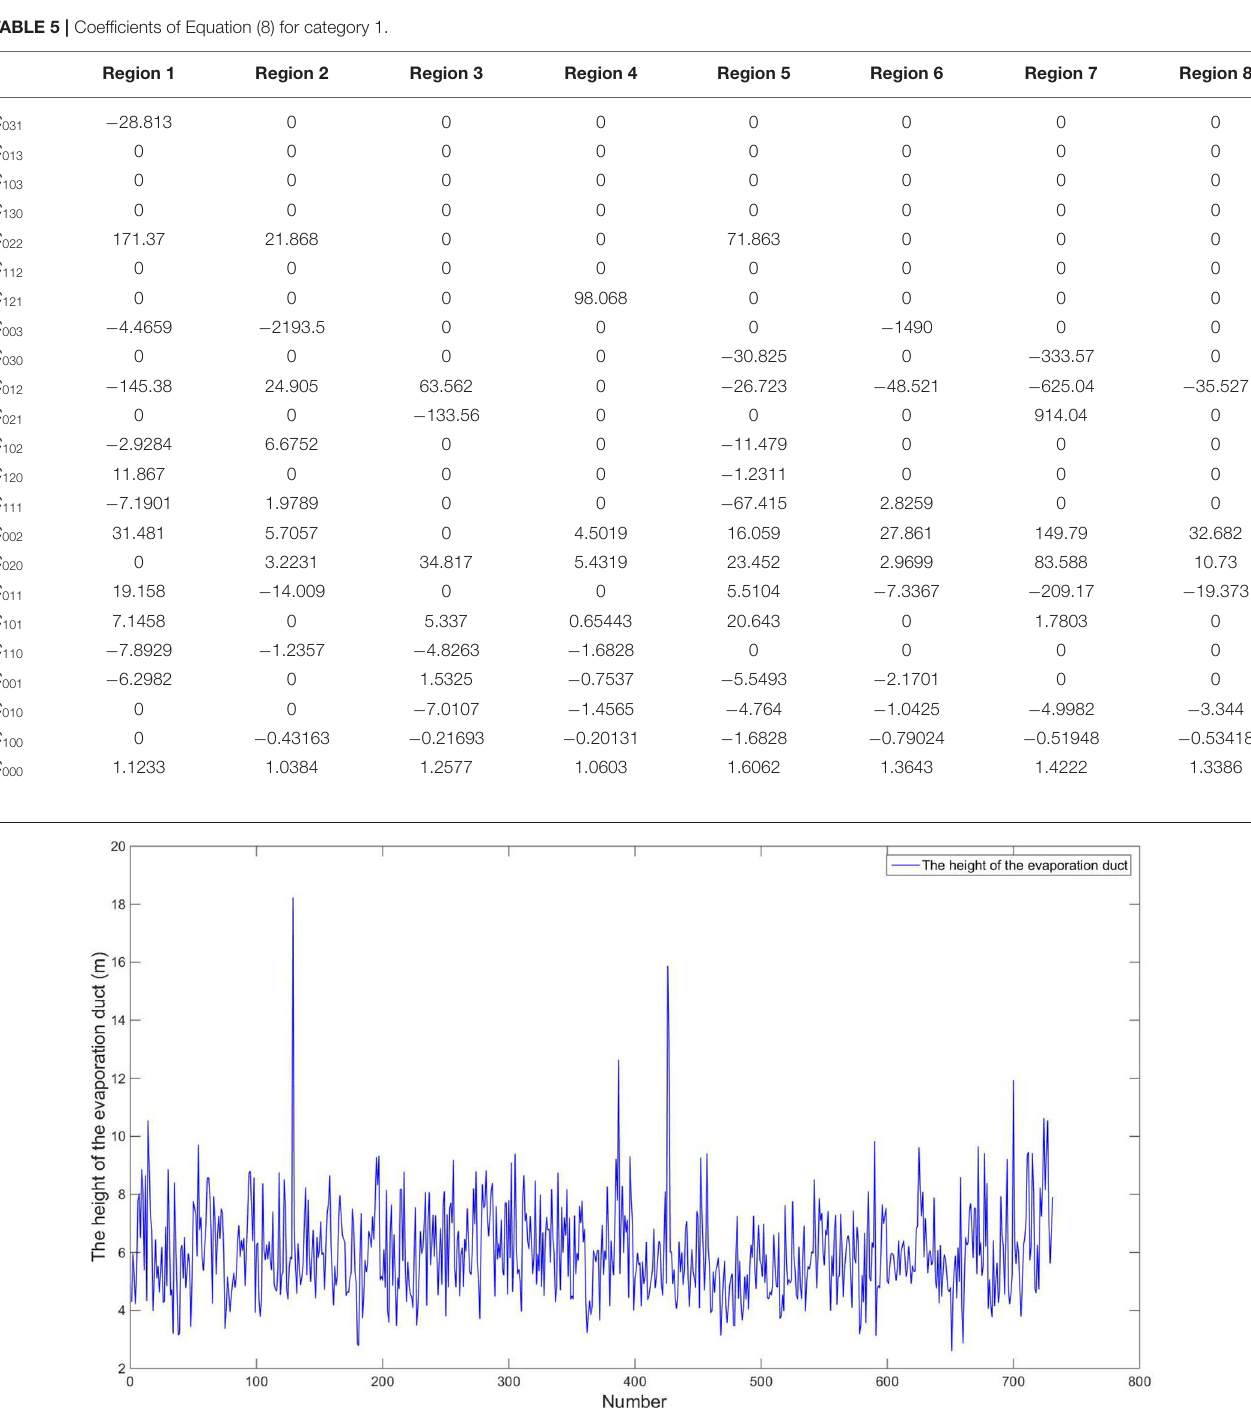
FIGURE 2 | Evaporation duct heights diagnosed by the Liuli 2.0 model. The samples in the figure are from January 1, 2008 to December 31, 2019, which have 731 samples in total. Each sample in turn corresponds to the number 1–731 of the